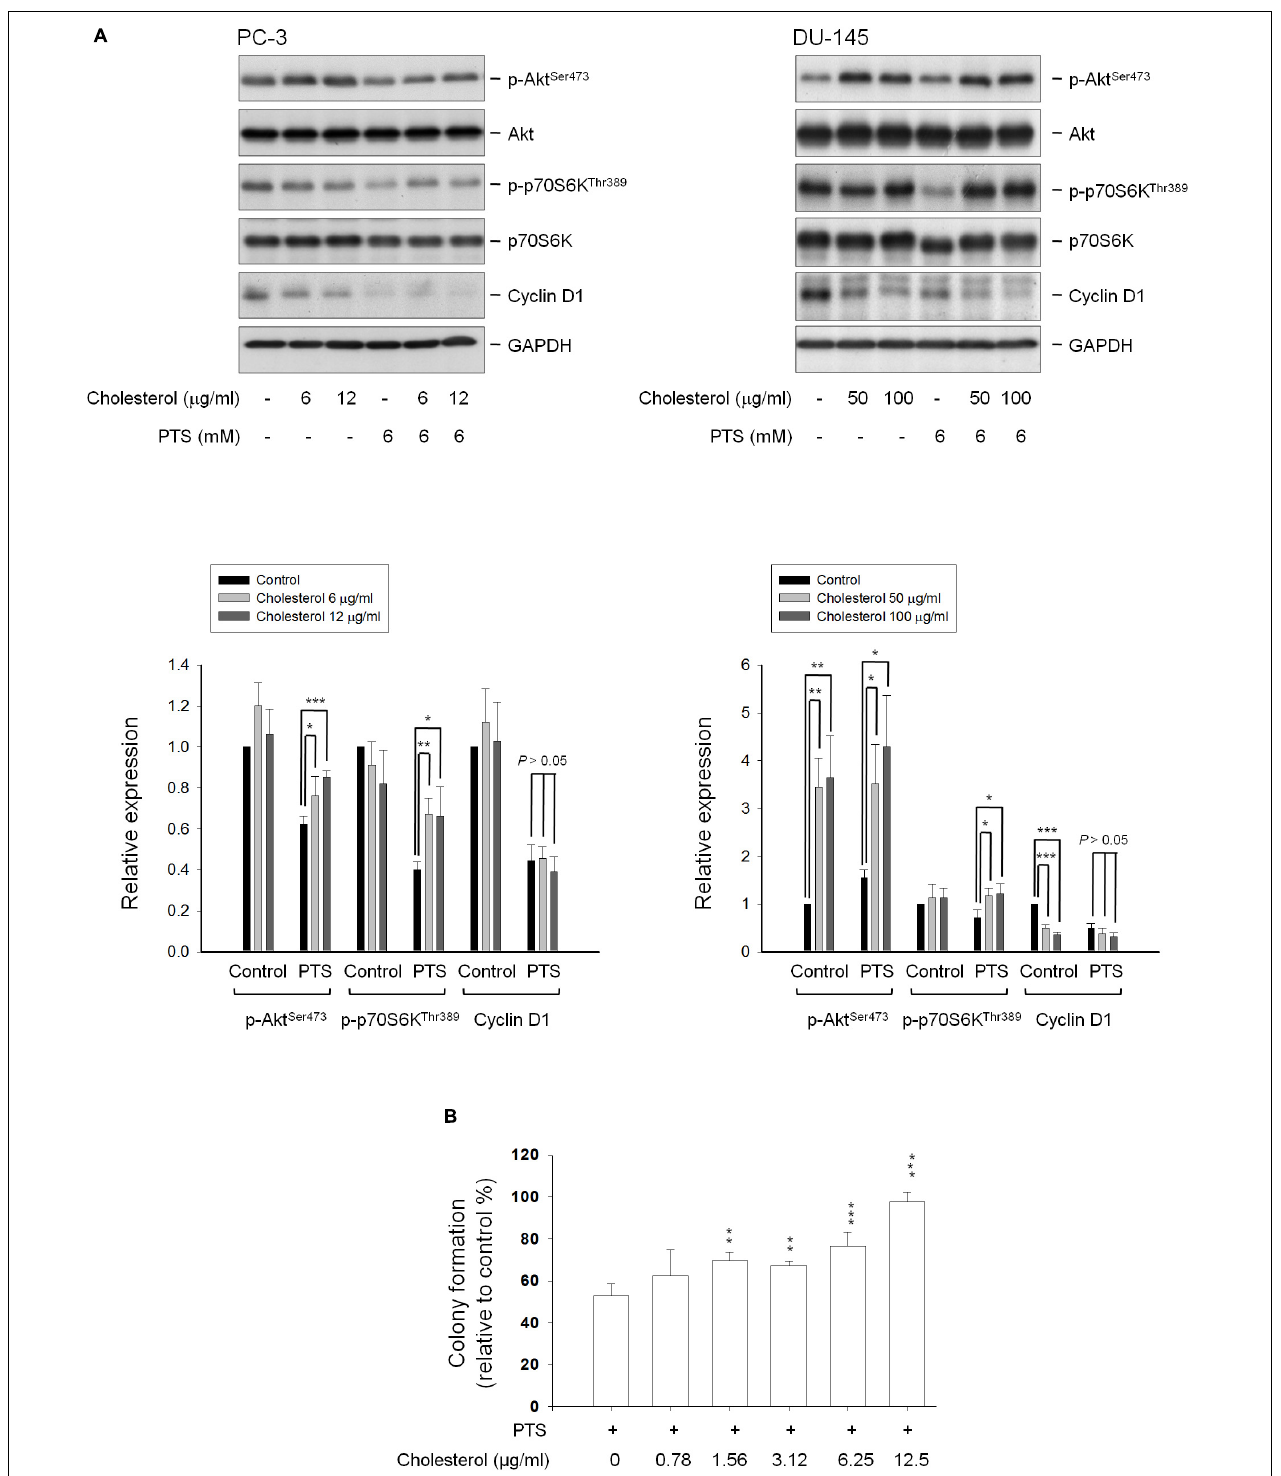
FIGURE 6 | Effect of cholesterol supplement on PTS-mediated effects. (A) PC-3 and DU-145 cells were incubated in the absence or presence of the indicated agent for 1 h. After treatment, the cells were harvested and lysed for the detection of protein expressions by Western blot analysis. The expression was quantified using Image Lab Software 6.0 (BIO-RAD). (B) PC-3 cells were incubated in the presence of the indicated agent (PTS, 1.5 mM) for 10 days. After treatment, cells were fixed and stained for colony formation assay. Data are expressed as mean ± SD of three determinations. ∗ P < 0.05, ∗∗ P < 0.01, ∗∗∗ P < 0.001 compared with PTS alone.